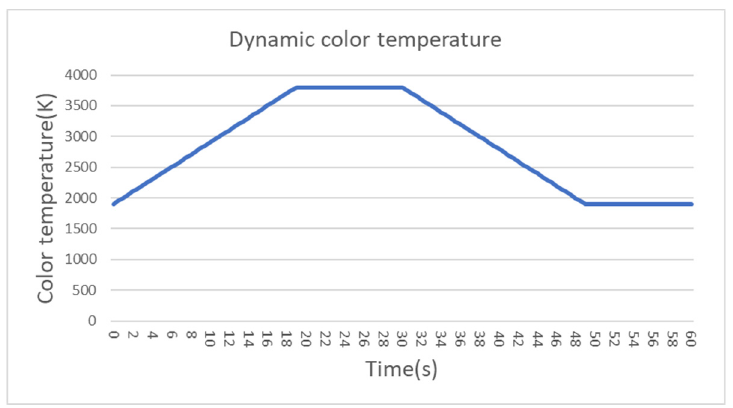
Figure 14. Dynamic color temperature. Table 1. Dynamic color temperature affects the measurement results of melatonin. The spectrum is